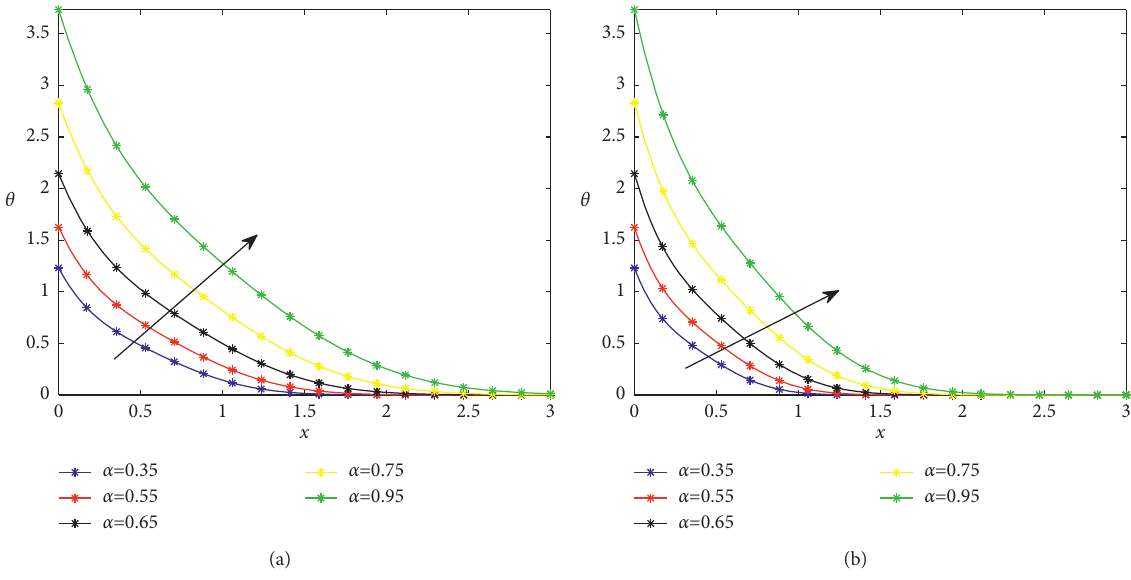
Figure 5: Concentration for different values of the order α for Sc � 10 (a) and Sc � 20 (b).